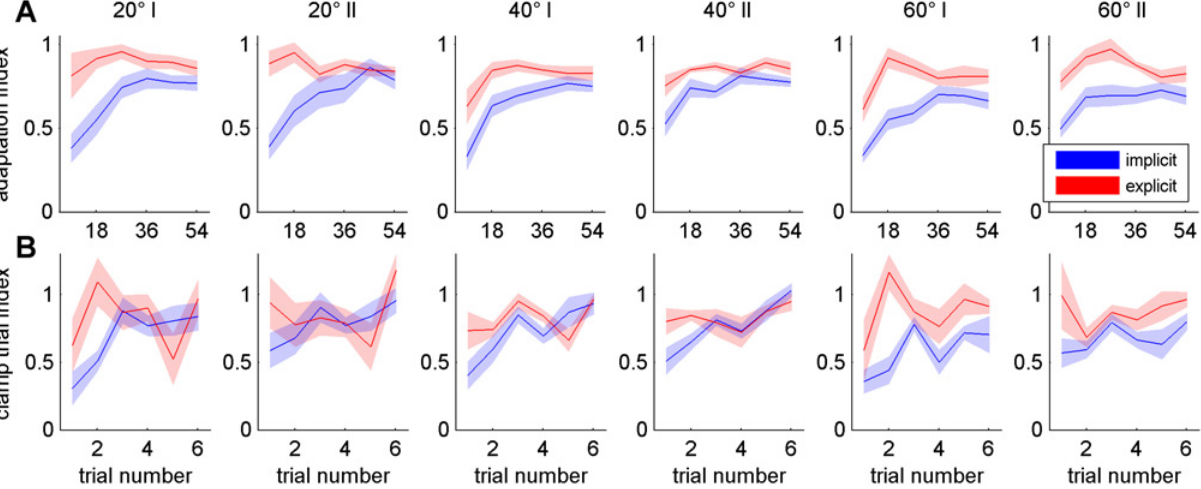
Fig 3. Adaptation and clamp trial indices. Mean adaptation (A) and clamp trial indices (B) of implicit (blue) and explicit (red) participants. The shaded area indicates standard errors. Note that a bin size of nine trialswas used for calculation of the adaptation index. For the clamp trial index bin size of one trial was used in this figure for illustrative purposes, but bin size of three trials was used for statistical analysis. For the adaptation index statistical analysis revealed significant effects of Group (p < 0.01), Bin (p < 0.001), Block Order (p < 0.05), Bin × Group (p < 0.001) and Bin × Block Order (p < 0.01). For the clamp trial index the analysis yielded significant effects of Group (p < 0.05), Bin (p < 0.01), Block Order (p < 0.05) and Bin × Group (p < 0.01). Both analyses revealed no significant effects of Rotation Size or any other interaction (all p >